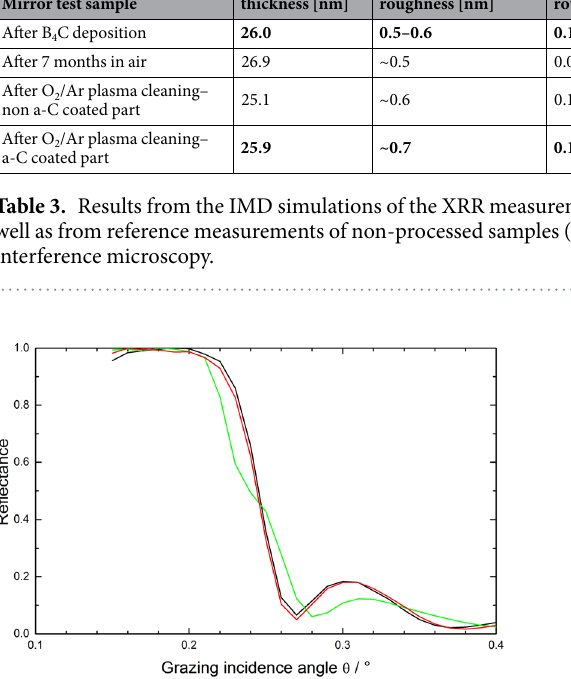
Figure 3. Comparison of XRR total reflection data at low grazing incidence angles for a pristine B 4 C-coated test mirror (black line) and after a-C coating plus subsequent O 2 /Ar plasma cleaning (green line: formerly a-C coated area; red line: non a-C coated